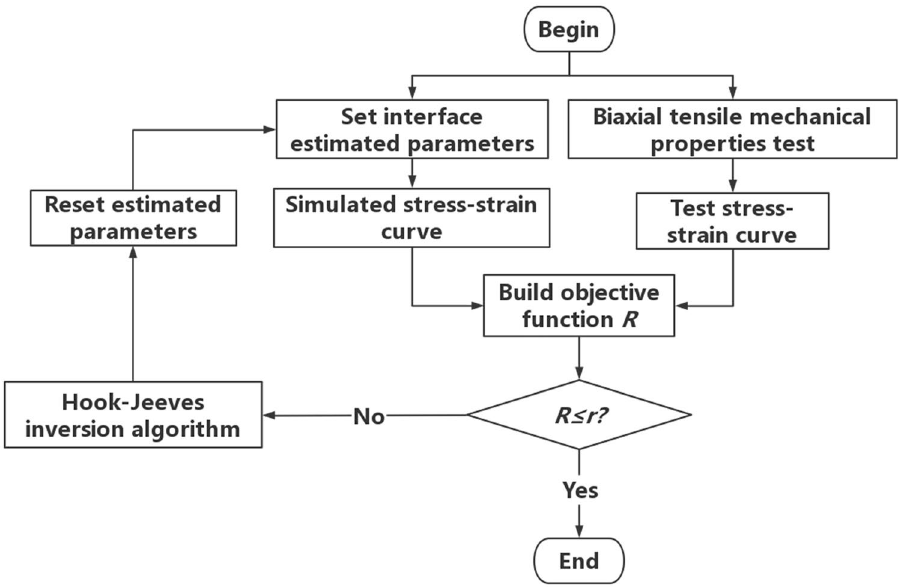
Figure 16. Inversion program of the paramete of